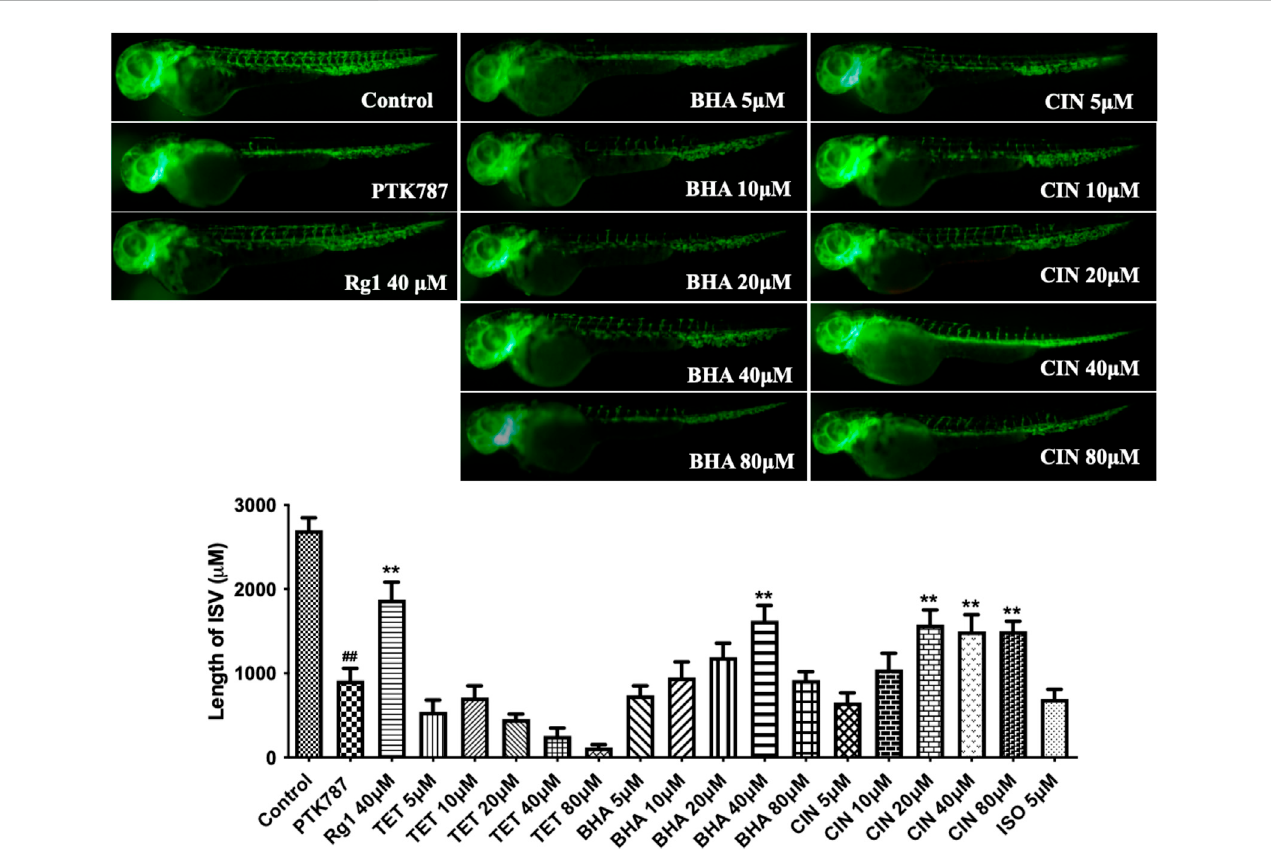
FIGURE 9 1-beta-hydroxyalantolactone(BHA)andCinobufotalin(CIN)stimulatedangiogenesisinazebra fi shmodel.Lateralviewofzebra fi shembryostreatedwith DMSO (0.1%, Control), PTK787 (0.2 μ g/mL), PTK 787 plus ginsenoside Rg1 (Rg1 40 μ M, positive control), or PTK 787 plus the test individual metabolites from TCM (5, 10, 20, 40, and 80 μ M) for 24 h. 1-beta-hydroxyalantolactone (BHA) and cinobufotalin (CIN) dose-dependently restored angiogenesis in ISVs against PTK787-inducedimpairment.Tetrahydeopalmatine(TET)worsenedtheeffectofPTK787andisoalantolactone(ISO)causedlethalityat10 μ Mandhigher concentrations. Quanti fi cation of total length of ISVs in different groups from three independent experiments. Statistical analysis data were shown as mean ± SEM ( n ≥ 8). The comparison between groups was performed by student ’ s test. ## p < 0.01 versus Control group; ** p < 0.01 versus PTK787-treated